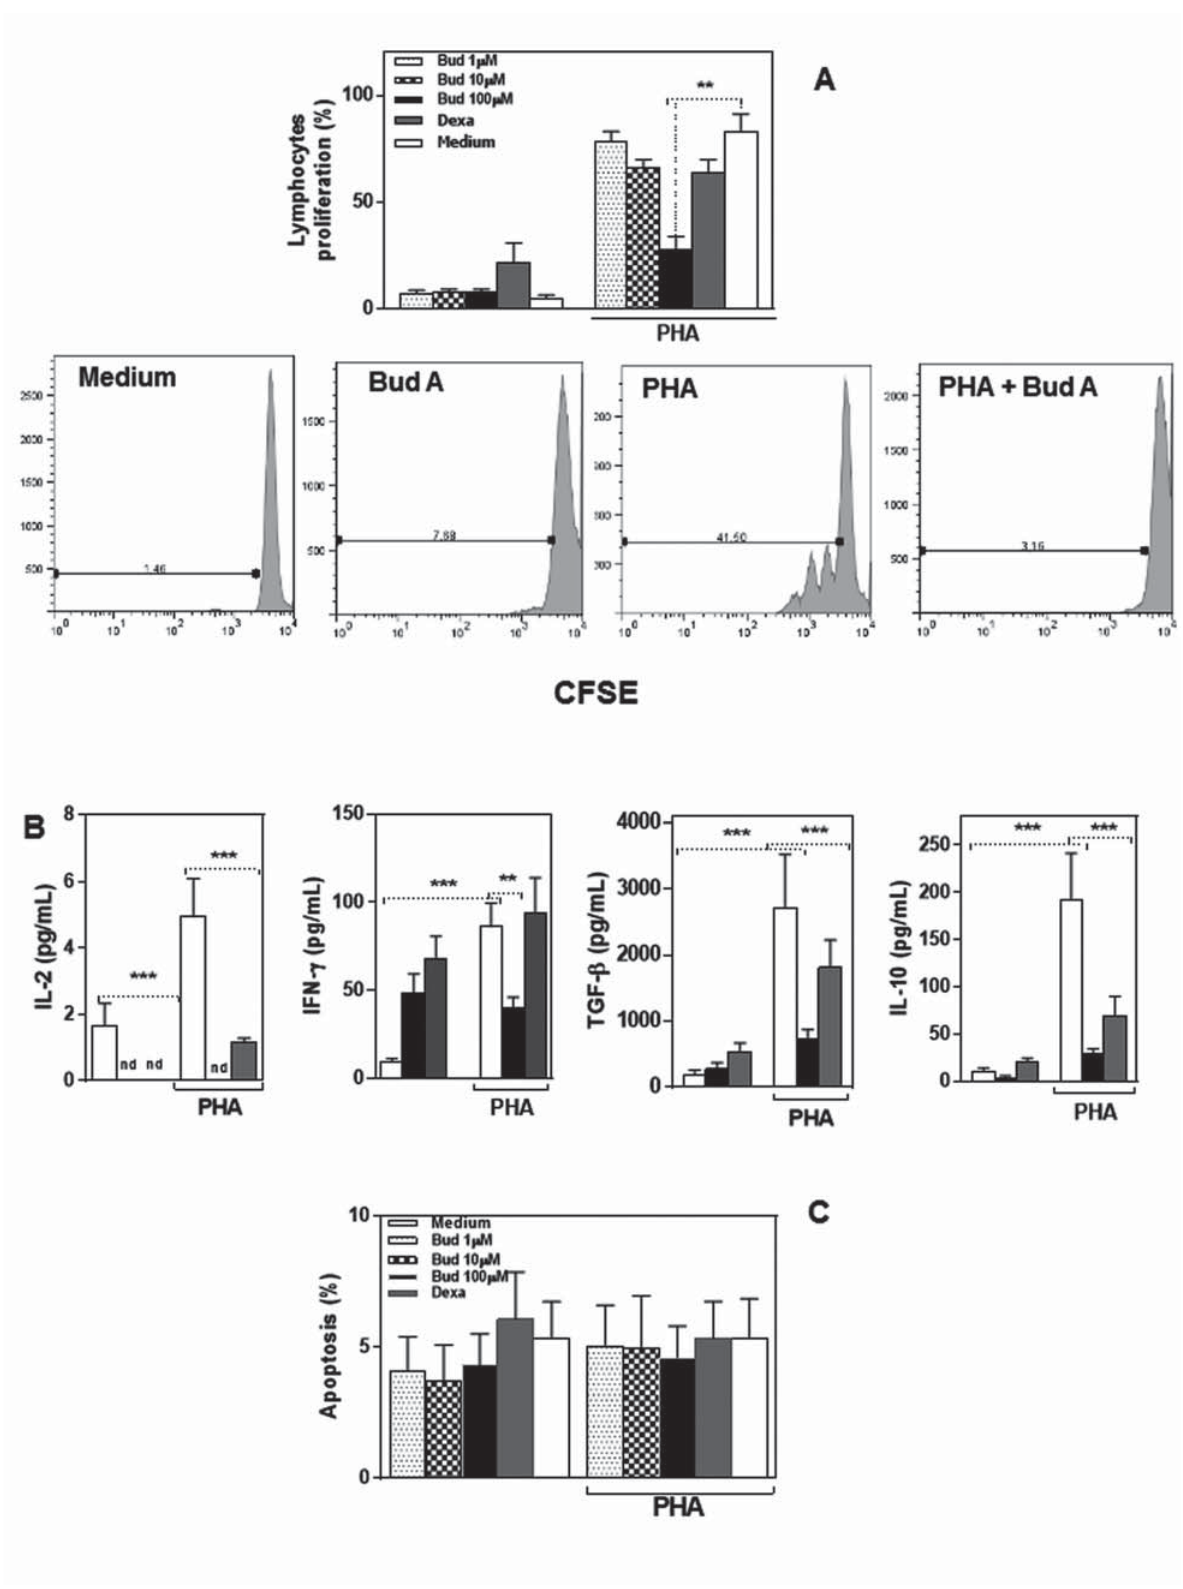
Figure 2- Budlein A inhibited T cell proliferation. (A) Flow cytometric analysis of proliferative response of PBMC cultured with Budlein A, dexamethasone, and PHA (1.5 mM) for 96 h. (B) IL-2, IFN-gamma, TGF-beta, and IL10 concentration in supernatant were analyzed by ELISA. (C) Flow cytometric analysis of apoptosis. The bars represent the mean±SEM of (cid:89)(cid:68)(cid:79)(cid:88)(cid:72)(cid:86)(cid:3)(cid:82)(cid:69)(cid:87)(cid:68)(cid:76)(cid:81)(cid:72)(cid:71)(cid:3)(cid:73)(cid:82)(cid:85)(cid:3)(cid:72)(cid:68)(cid:70)(cid:75)(cid:3)(cid:86)(cid:88)(cid:69)(cid:77)(cid:72)(cid:70)(cid:87)(cid:3)(cid:76)(cid:81)(cid:71)(cid:76)(cid:89)(cid:76)(cid:71)(cid:88)(cid:68)(cid:79)(cid:79)(cid:92)(cid:3)(cid:87)(cid:72)(cid:86)(cid:87)(cid:72)(cid:71)(cid:17)(cid:3)(cid:13)(cid:83)(cid:31)(cid:19)(cid:17)(cid:19)(cid:24)(cid:15)(cid:3)(cid:13)(cid:13)(cid:83)(cid:31)(cid:19)(cid:17)(cid:19)(cid:20)(cid:15)(cid:3)(cid:13)(cid:13)(cid:13)(cid:83)(cid:31)(cid:19)(cid:17)(cid:19)(cid:19)(cid:20)(cid:3)(cid:90)(cid:68)(cid:86)(cid:3)(cid:70)(cid:82)(cid:81)(cid:86)(cid:76)(cid:71)(cid:72)(cid:85)(cid:72)(cid:71)(cid:3)(cid:86)(cid:87)(cid:68)(cid:87)(cid:76)(cid:86)(cid:87)(cid:76)(cid:70)(cid:68)(cid:79)(cid:79)(cid:92)(cid:3)(cid:86)(cid:76)(cid:74)(cid:81)(cid:76)(cid:191)(cid:70)(cid:68)(cid:81)(cid:87)(cid:3) when compared with the